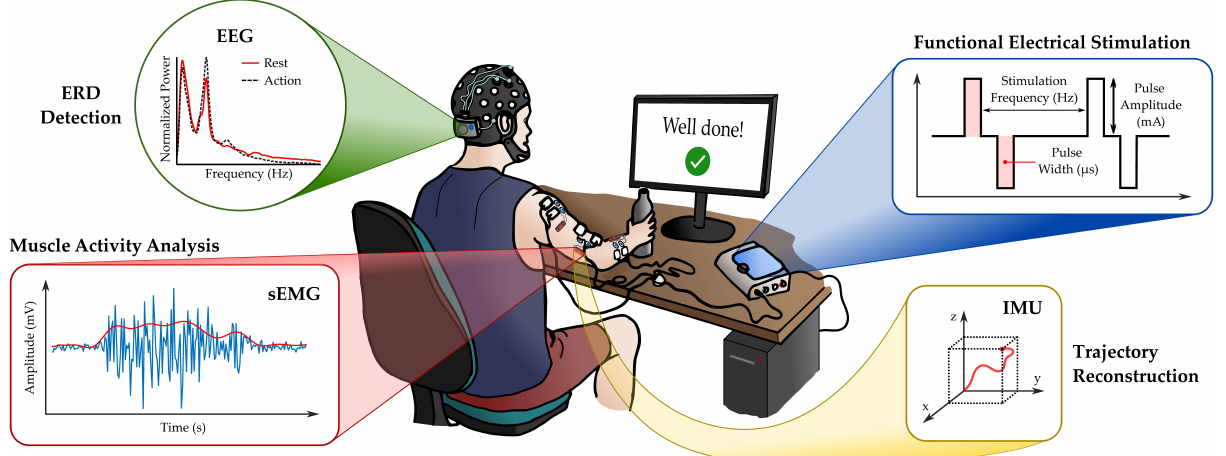
Figure 2. Overview of the system. The patient is instructed to perform the reaching of an object, typically. EEG electrodes are placed on the motor areas and stabilized by a comfortable helmet. sEMG and inertial sensors are placed on the limb of interest, next to the stimulation electrodes. A central unit processes acquired data to activate the FES when the subject needs help to reach the target. A monitor provides feedbacks encouraging the user.